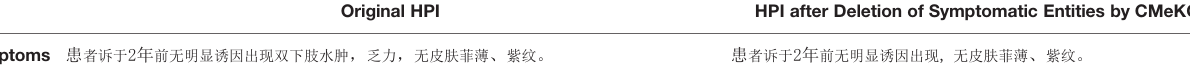
Bold values in this table represent highest AUC value in each ML based model.